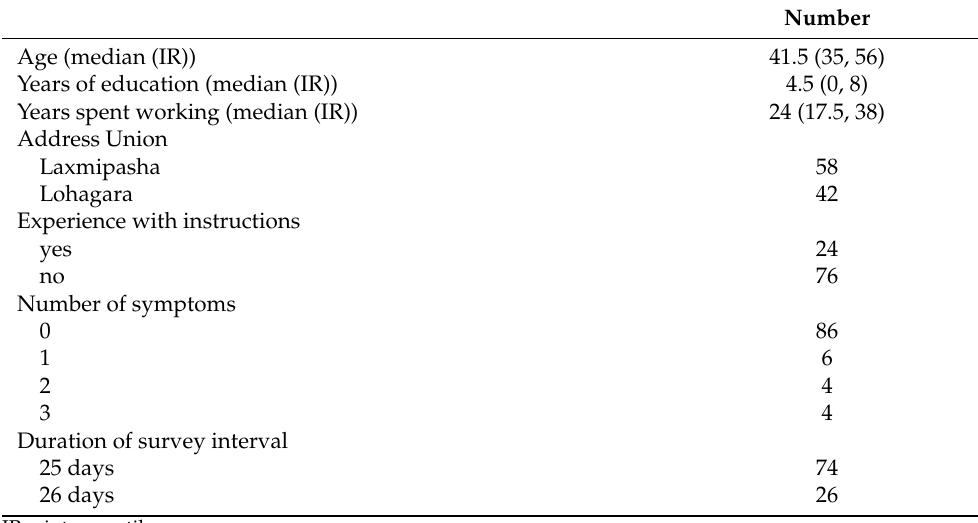
Table 1. Participant characteristics.